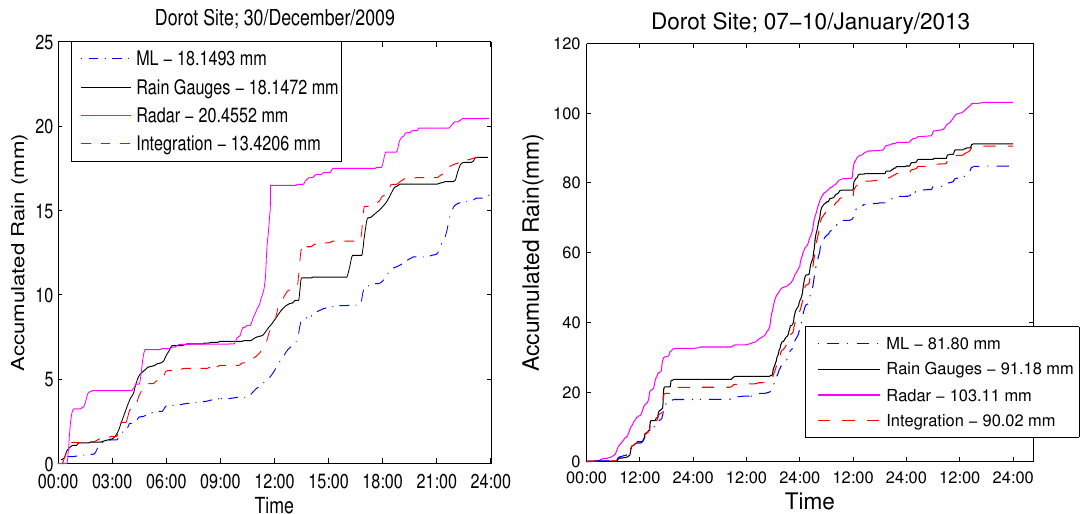
Figure 17. Accumulated rain intensity (mm) for the Dorot site, with 12 ML surrounding the site. Left: 30 December 2009 (24h of rain); Fig. 17. The accumulated rain intensity (mm) for Dorot site, with 12 ML surrounding the site. Left - right: 7–10 January 2013 (96h of rain). 30/Dec/2009 (24 hours of rain event), Right - 07-10/Jan/2013 (96 hours of rain event)